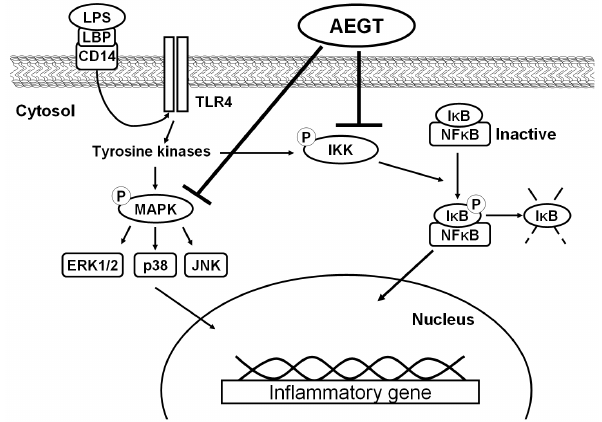
Figure 8. A proposed model for the inhibitory action of AEGT on LPS-induced inflammation. AEGT inhibits IKK a / b and MAPKs phosphorylation, eventually blocking NF- k B activation and proinflam- matory gene